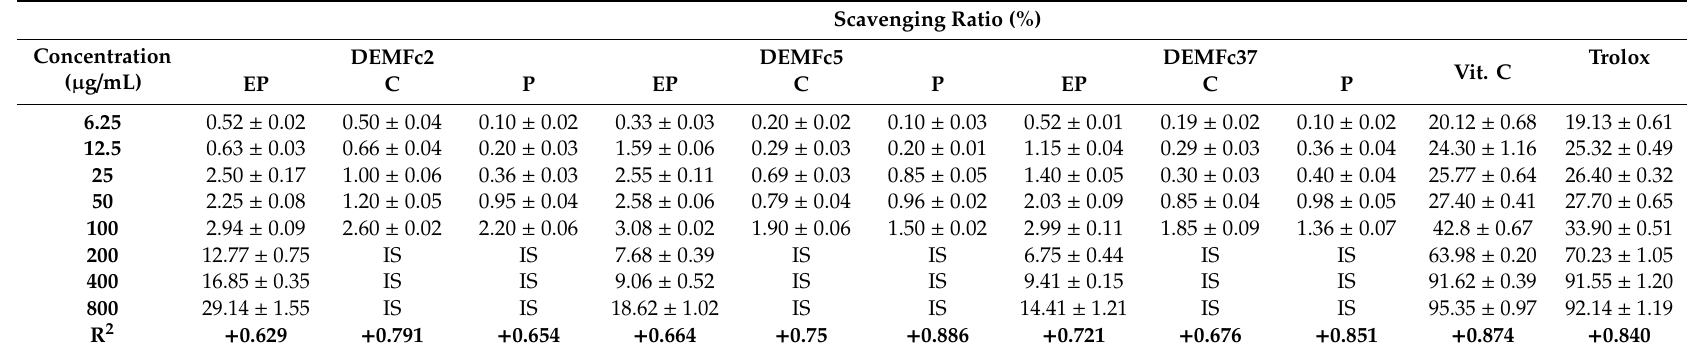
Table 4. Scavenging ability (determined with the ABTS method) of the EPS obtained from cultures of three F. culmorum strains. comparison of ethanol precipitate EPS ( EP ), crude EPS ( C ), and proteolysed EPS ( P ) used in a concentration range of 6.25–100 µ g / mL and ethanol precipitate EPS ( EP ) used in a concentration range